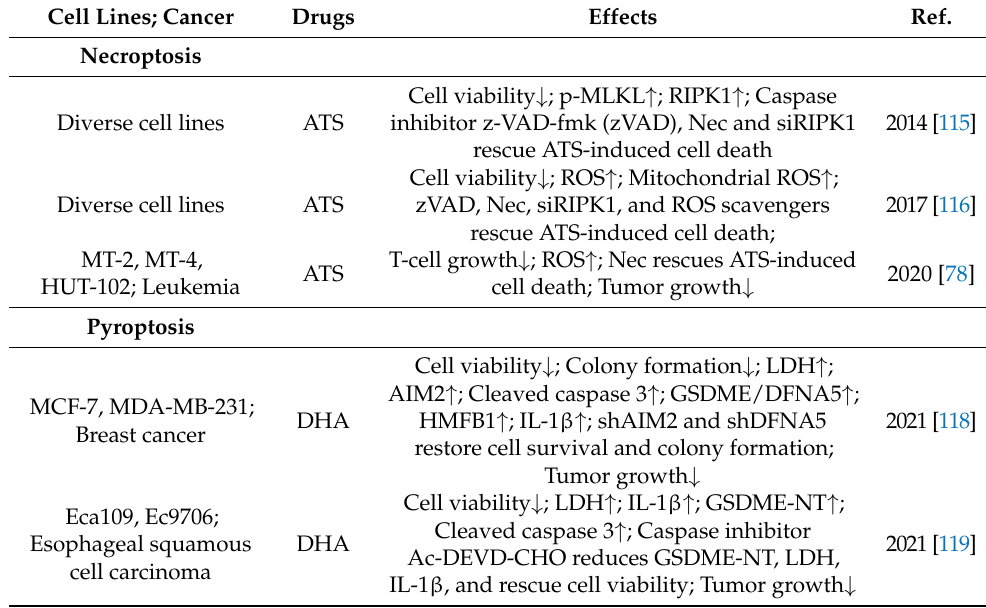
Table 4. List of studies from the last 10 years investigating the effect of ART-type drugs related to necroptosis and pyroptosis in cancer cells with information on the model systems used, the ART-type drugs tested and the major findings of the